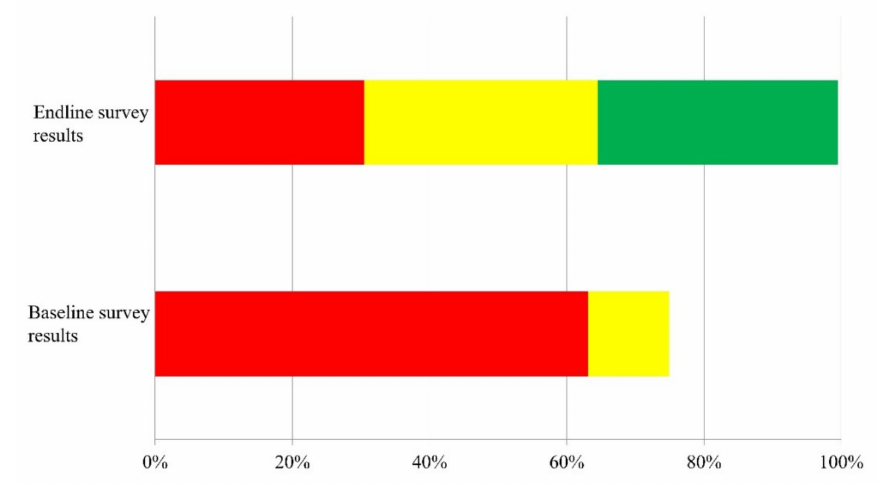
Figure 1. Sanitation coverage in the intervention group by the latrine type (red colour: simple pit latrine; yellow colour: partially improved latrine; and green colour: improved latrine. The white space in the bar denotes the proportion of households without any type of household latrine. The baseline